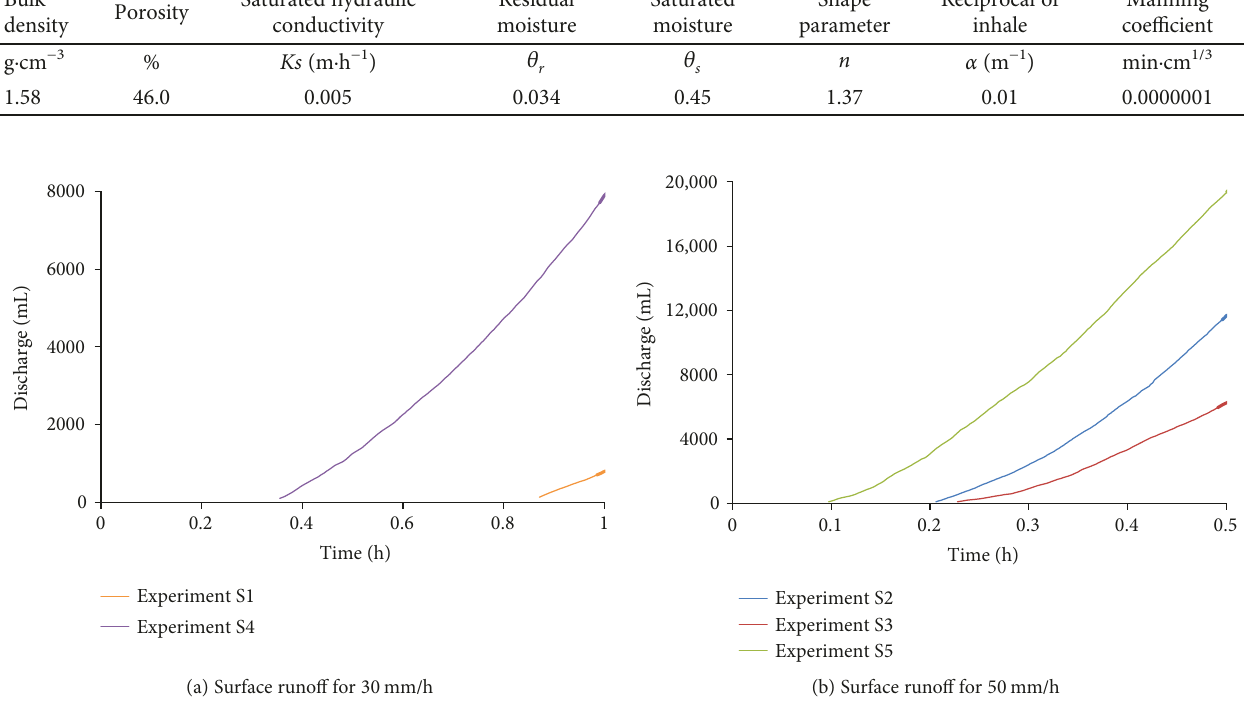
Figure 4: Surface runo ff in comparison experiment.